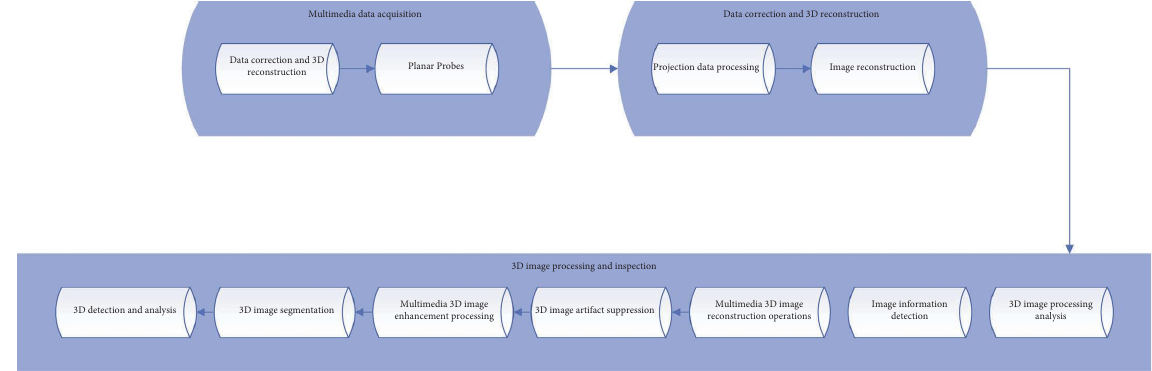
Figure 1: Flow of multimedia intelligent 3D image